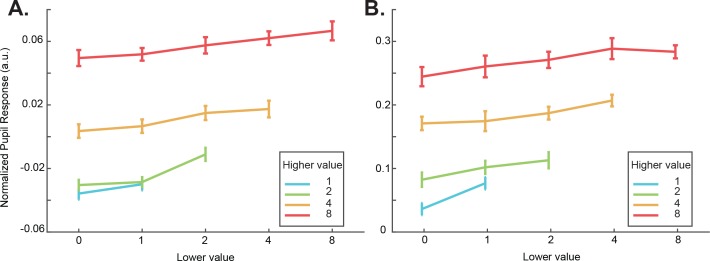
Pupil responses for each cue combination.(A) Pupil responses for each cue combination for monkey G. The cue combinations with the same higher value cue form groups, which are indicated by the same color and joined together by line segments. (B) Pupil responses for monkey D. One-way ANOVAs with Bonferroni corrections were used to test if there are significant differences within each group. See also Supplementary file 1, Table 2.